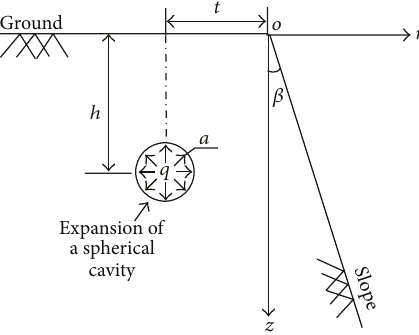
Figure 2: Expansion of a spherical cavity near the sloping ground.